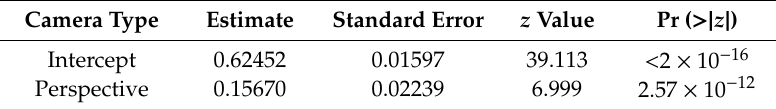
Table 1. The results of logistic regression by investigating the e ff ect of camera type. Camera Type